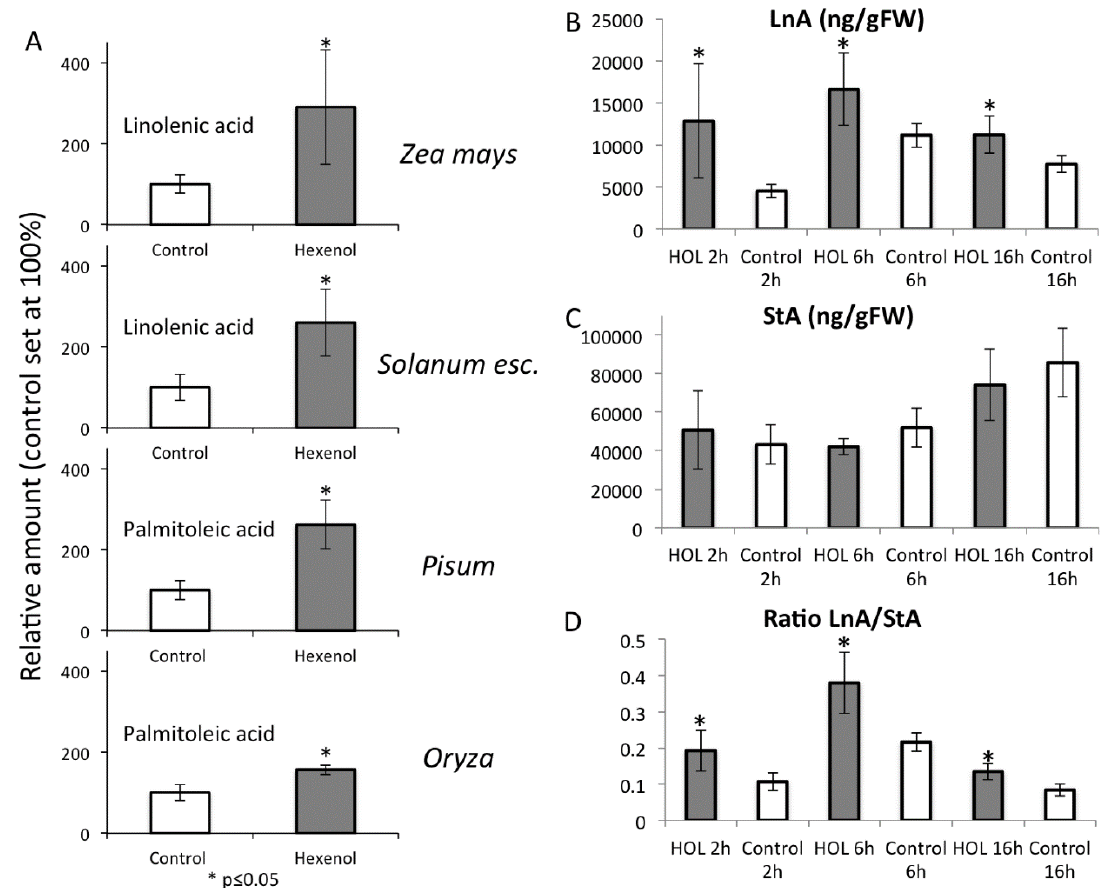
Figure 5. ( A ) Increases in free fatty acids in different plant species after exposure to Z -3-hexenol as our model GLV. Plants were exposed to 20 µg of Z -3-hexenol (HOL) for 15 min and free fatty acids analyzed by GC/MS. Note that Zea and Solanum show increased linolenic acid (LnA) levels, whereas in Pisum and Oryza palmitoleic acid was increased. Relative amounts are displayed with free fatty acid levels in control plants set at 100%. * denotes significant differences ( t- test, p ≤ 0.05). ( B – D ) Effects of prolonged GLV treatments on free linolenic acid levels in maize leaves. Maize plants were exposed to 20 μg of GLV for the time indicated. ( B ) Amounts of free LnA after 2, 6, and 16 h; ( C ) Amounts of free stearic acid (StA) after 2, 6, and 16 h; ( D ) Ratios of LnA to StA after 2, 6, and 16 h. * denotes significant differences ( t- test, p ≤ 0.05). N = 5, error bars represent standard deviation.